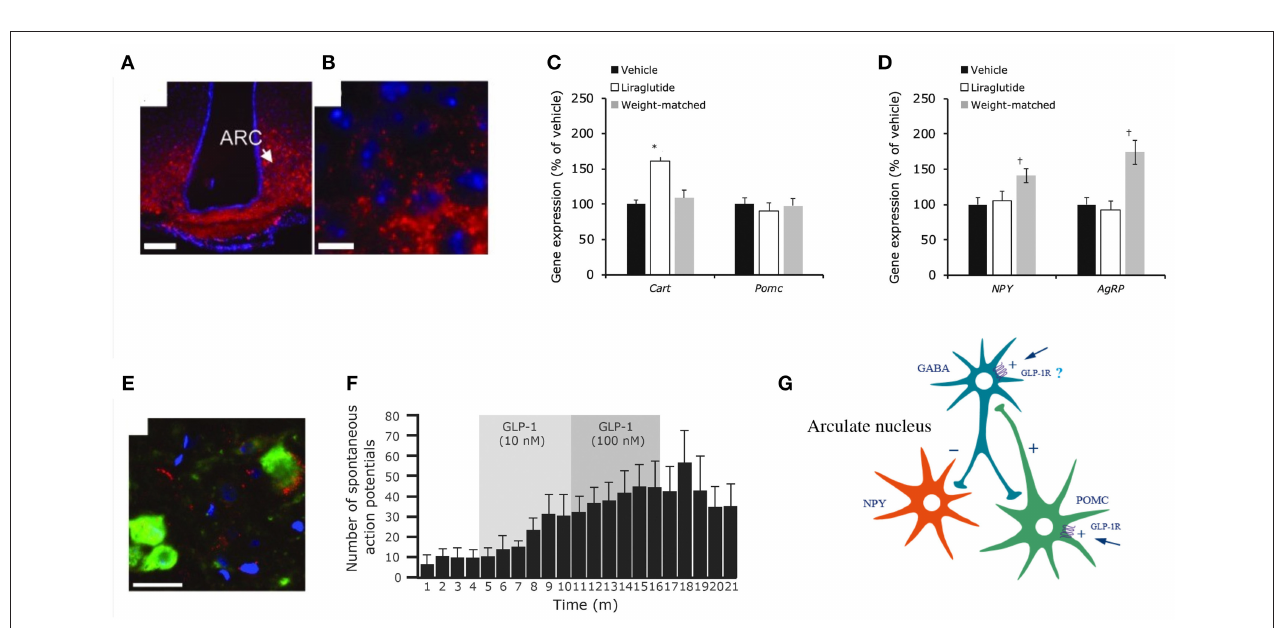
FIGURE 8 | Liraglutide and the mouse brain. Distribution of liraglutide 594 or exendin(9-39) 594 in brain. (A,B) liraglutide 594 had access to ARC, in which it bound the GLP-1R and internalized. (B) High-magnification image showed that liraglutide 594 was internalized and the fluorescent signal was located in the cytoplasm. Staining, Hoechst nuclear stain (blue) and liraglutide 594 /exendin(9-39) 594 (red). Scale bars: 100 µ m. Liraglutide treatment regulates ARC gene expression and ARC neuronal activity. (C) Liraglutide treatment for 28 days in DIO rats significantly increased mean Cart mRNA levels in the ARC (* p < 0.001 liraglutide vs. vehicle and vs. weight matched), whereas Pomc expression was unaffected. (D) Npy and Agrp mRNA levels were significantly increased in weight-matched rats–but not following treatment with liraglutide († p < 0.05 weight matched vs. vehicle and vs. liraglutide). Data are mean ± SEM, and statistical analyses were performed using 1-way ANOVA, with Fisher’s post hoc test. Images (E,F) show neuronal accumulation and activity following GLP-1R simulation. Specifically, panel (E) shows CART- and liraglutide 594 -positive cells shown as mean ± SEM. Staining, Hoechst nuclear strain (blue), liraglutide594 (red) and CART (green). Scale bar: 25 µ m. Panel (F) shows the effects of GLP-1(7-36)amide on firing rate of spontaneous action potentials in POMC/CART neurons. (G) Proposed regulation of neuronal activation by liraglutide. Summary diagram demonstrating the suggested regulatory pathway of GLP-1 on ARC NPY and POMC neurons. GLP-1 stimulates POMC neurons directly through the GLP-1R and is suggested to indirectly inhibit ARC-NPY neurons through a local inhibitory GABA neuron. ANOVA, analysis of variance; ARC, arcuate nucleus; CART, cocaine- and amphetamine-regulated transcript; DIO, diabetes induced obesity; GABA, gamma-amino butyric acid; GLP-1, glucagon-like peptide-1; GLP-1R, glucagon-like peptide-1 receptor; NYP, neuropeptide Y; POMC, proopiomelanocortin; SEM, standard error of the mean; veh, vehicle. Republished with permission of American Society For Clinical Investigation, from Secher et al. (117), Copyright 2018; permission conveyed through Copyright Clearance Center,